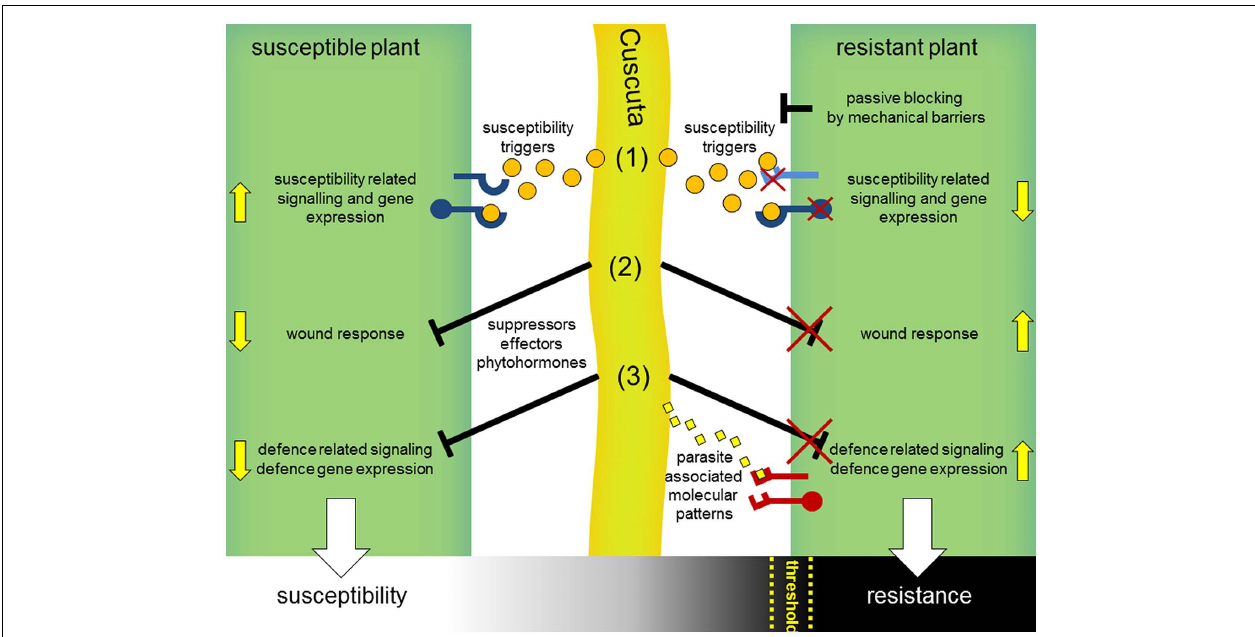
FIGURE 4 | Hypothetical model for interaction mechanisms of parasitic Cuscuta with susceptible and resistant host plants. Cuscuta ( middle , light green) attacking susceptible plants (left) release susceptibility triggers (orange dots) including common phytohormones and yet unknown signals, which get perceived by host plant receptors (blue) and consequently manipulate hosts to set on susceptibility-related responses and gene expression (1). In parallel, wound-related (2) and defense-related responses (3) that occur in the context of host penetration might get blocked by yet unknown suppressors. Resistant plants (right) might prevent a parasitic attack passively, e.g., by reinforced cell walls as mechanical barriers or by non-responsiveness to susceptibility triggers (1).